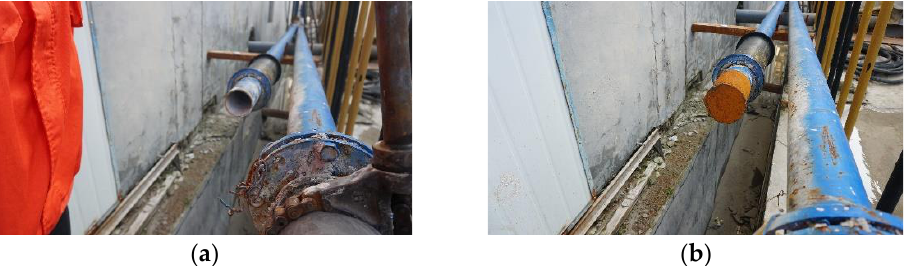
Figure 7. Schematic diagram of the pipeline before and after damp ( a ) Undamaged pipeline ( b ) damaged pipeline.